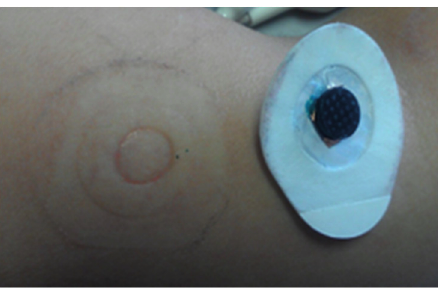
Figure 15. Skin condition after coin-shaped electrode/skin contact for 6 days.